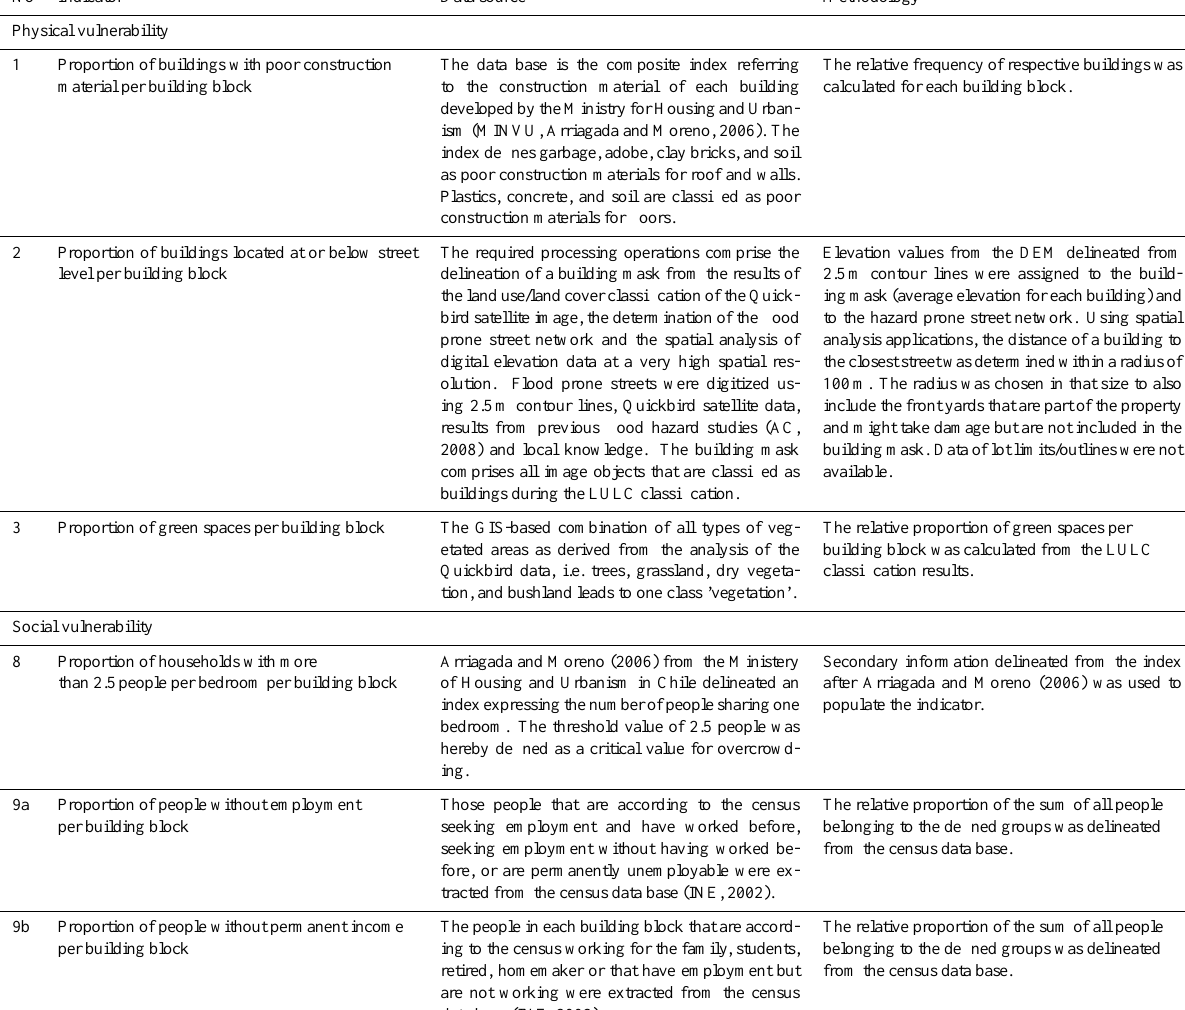
Table 4. Data source and methodology applied for the derivation of information for each vulnerability